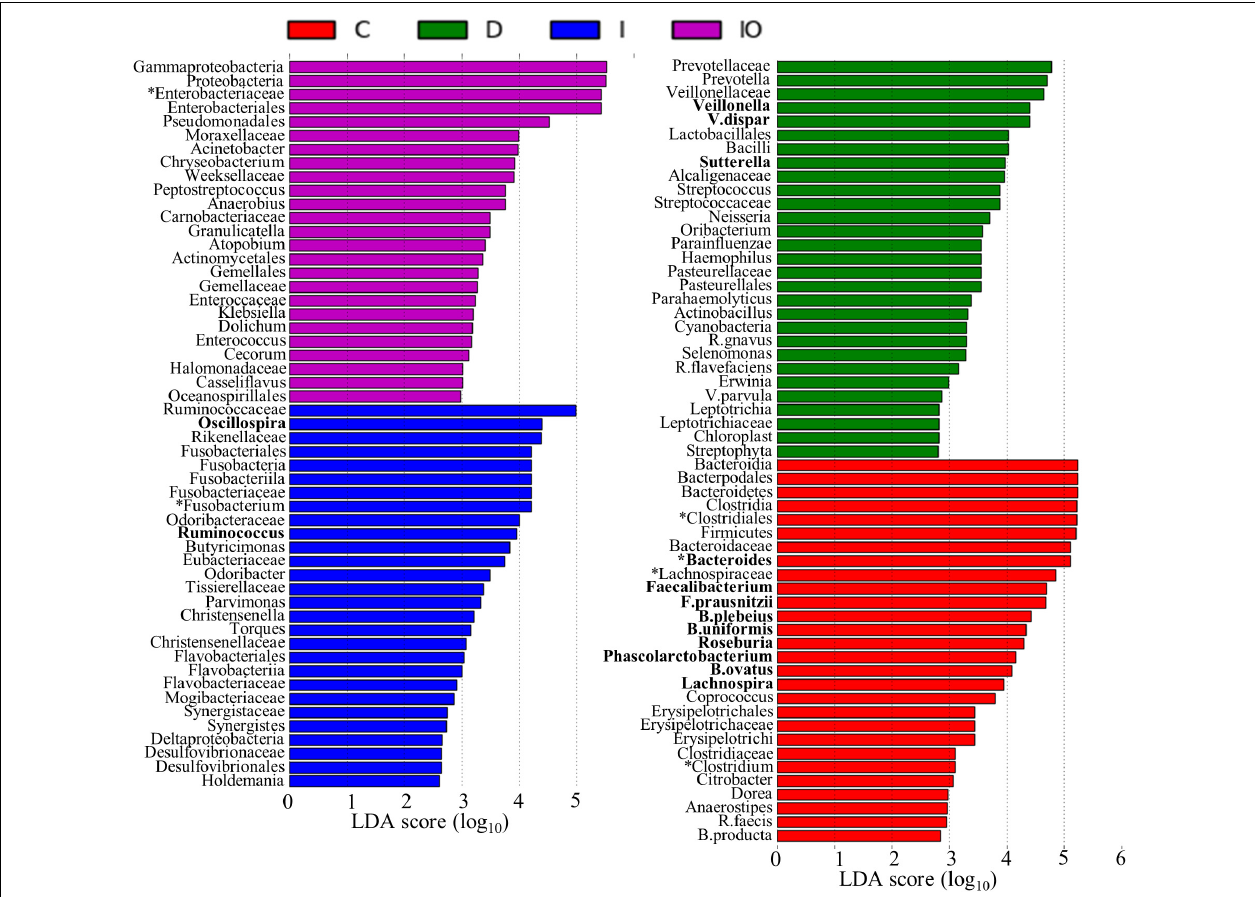
FIGURE 6 | Histogram representation of potential biomarkers. Potential biomarkers for each clinical group are presented by the LDA scores from the phylum to species. C, healthy individuals; D, CRC patients after chemotherapy; I, CRC patients before treatment; IO, CRC patients after surgical